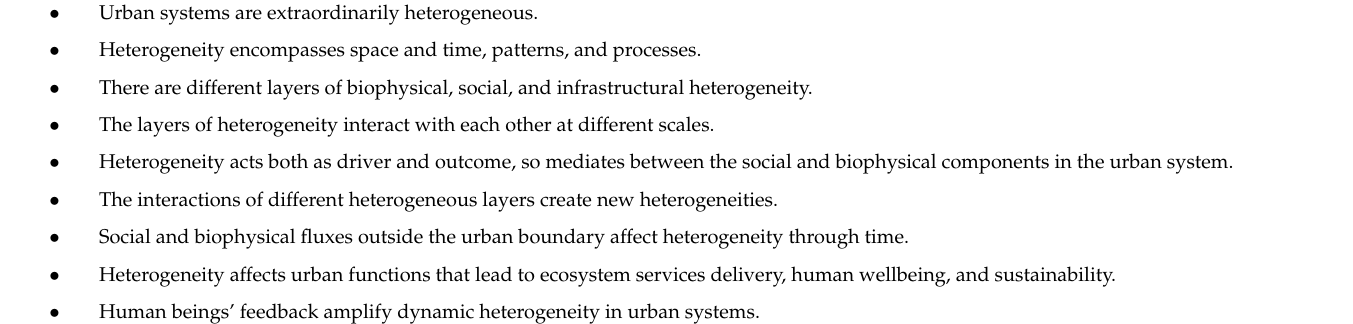
Table 2. The main attributes associated with h dynamic heterogeneity approach to elucidate UHI in an urban ecosystem (adapted from Pickett et al.